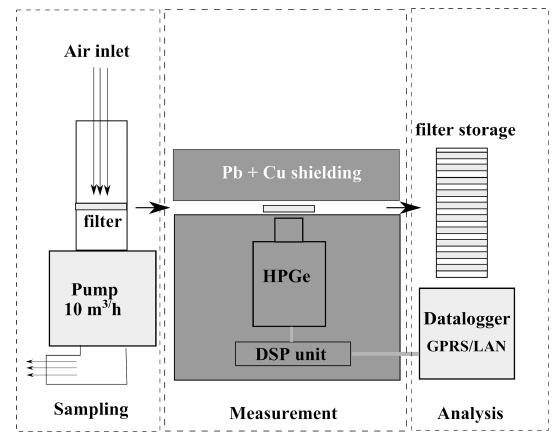
Figure 3. CEGAM system schematics. The activity deposition is measured using an HPGe detector above an aerosol filter after sam- pling in radiation shielding. LAN: local area network; DSP: digital signal processing; GPRS: general packet radio